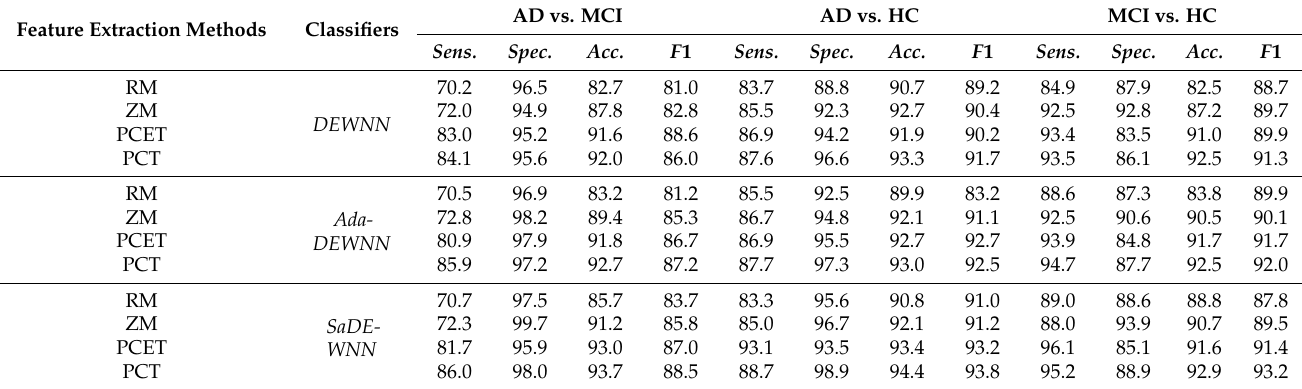
Classification of AD vs. HC: The classification results are shown in Table 2 (AD vs. HC column) in terms of accuracy, sensitivity, specificity for each feature set. The best results obtained by the PCT feature sets with the proposed SaDE-WNN are 94.4% accuracy, 88.7% sensitivity, 98.9% specificity, and 93.8 F1. The best results for the RM feature sets with SaDE-WNN are 93.3% accuracy, 87.6% sensitivity, 96.6% specificity, and 91.7 F1